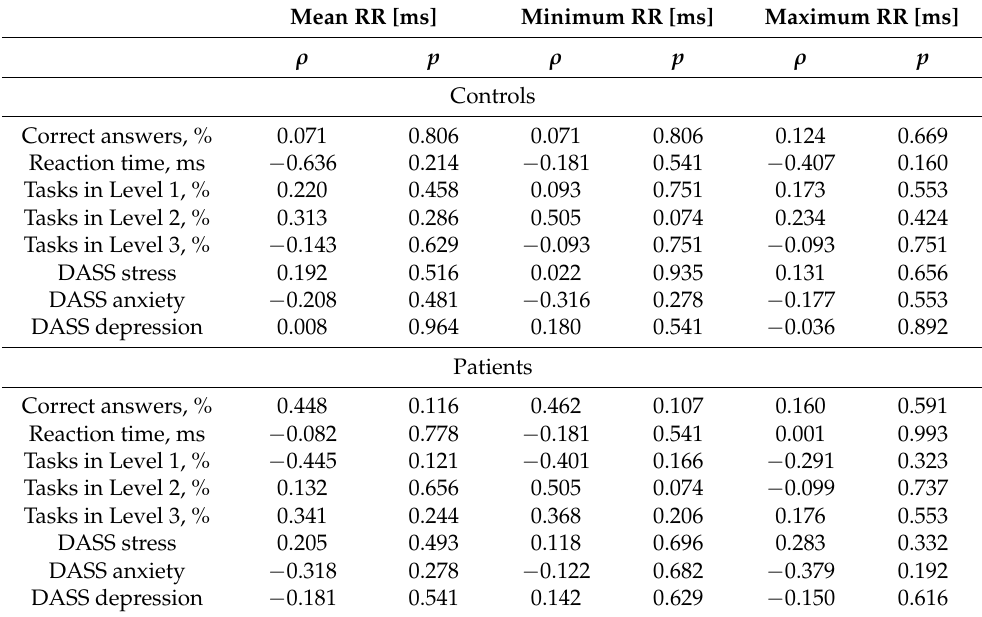
Table 2. Results of the correlation analysis between the ECG-derived parameters and performance and psychological variables in patients and controls at baseline.